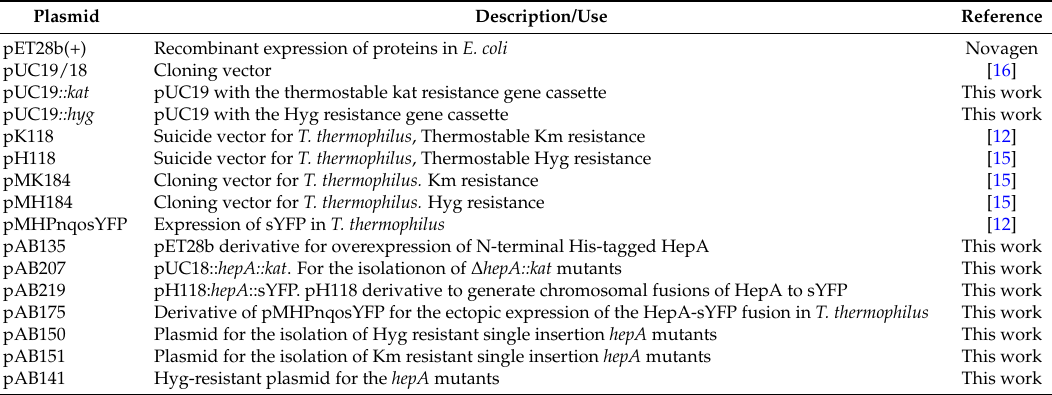
Table 3. Plasmids employed in this